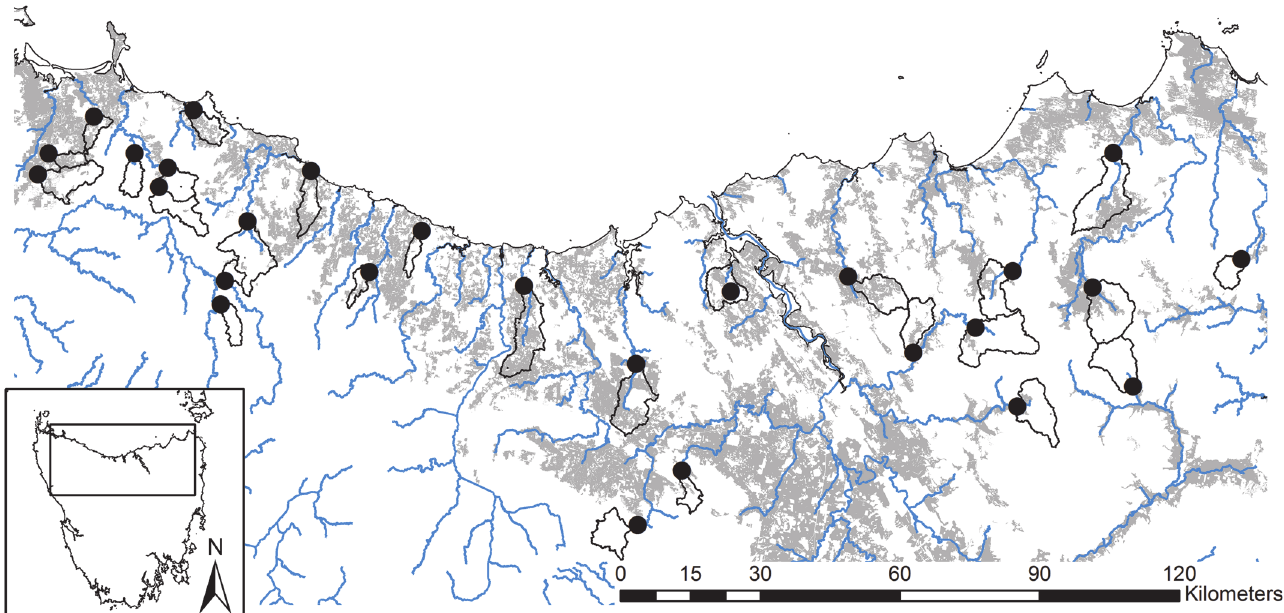
Fig 1. Map of study area and survey sites. Twenty-seven sites ( ● ) were surveyed across northern Tasmania over two years. Site catchments were independent (black lines) and covered a gradient of grazing intensity (0 to 80% grazing of total catchment areas; grey shading shows land used for grazing livestock). Land-use data were supplied by DPIPWE (2009), and other spatial data were extracted from the Conservation of Freshwater Ecosystem Values database (DPIWE 2005) and the Land Information System Tasmania (theLIST) ©